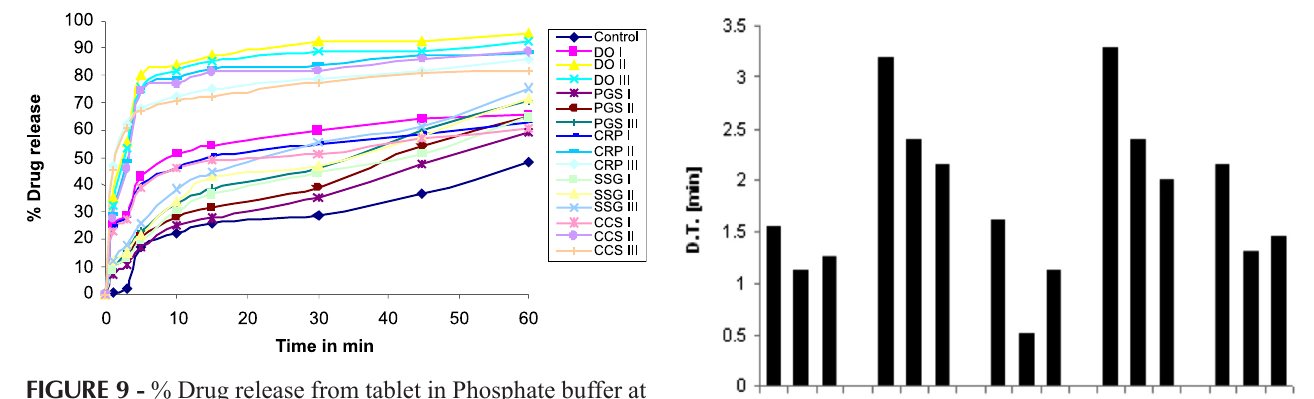
FIGURE 9 - % Drug release from tablet in Phosphate buffer at pH 6.8.